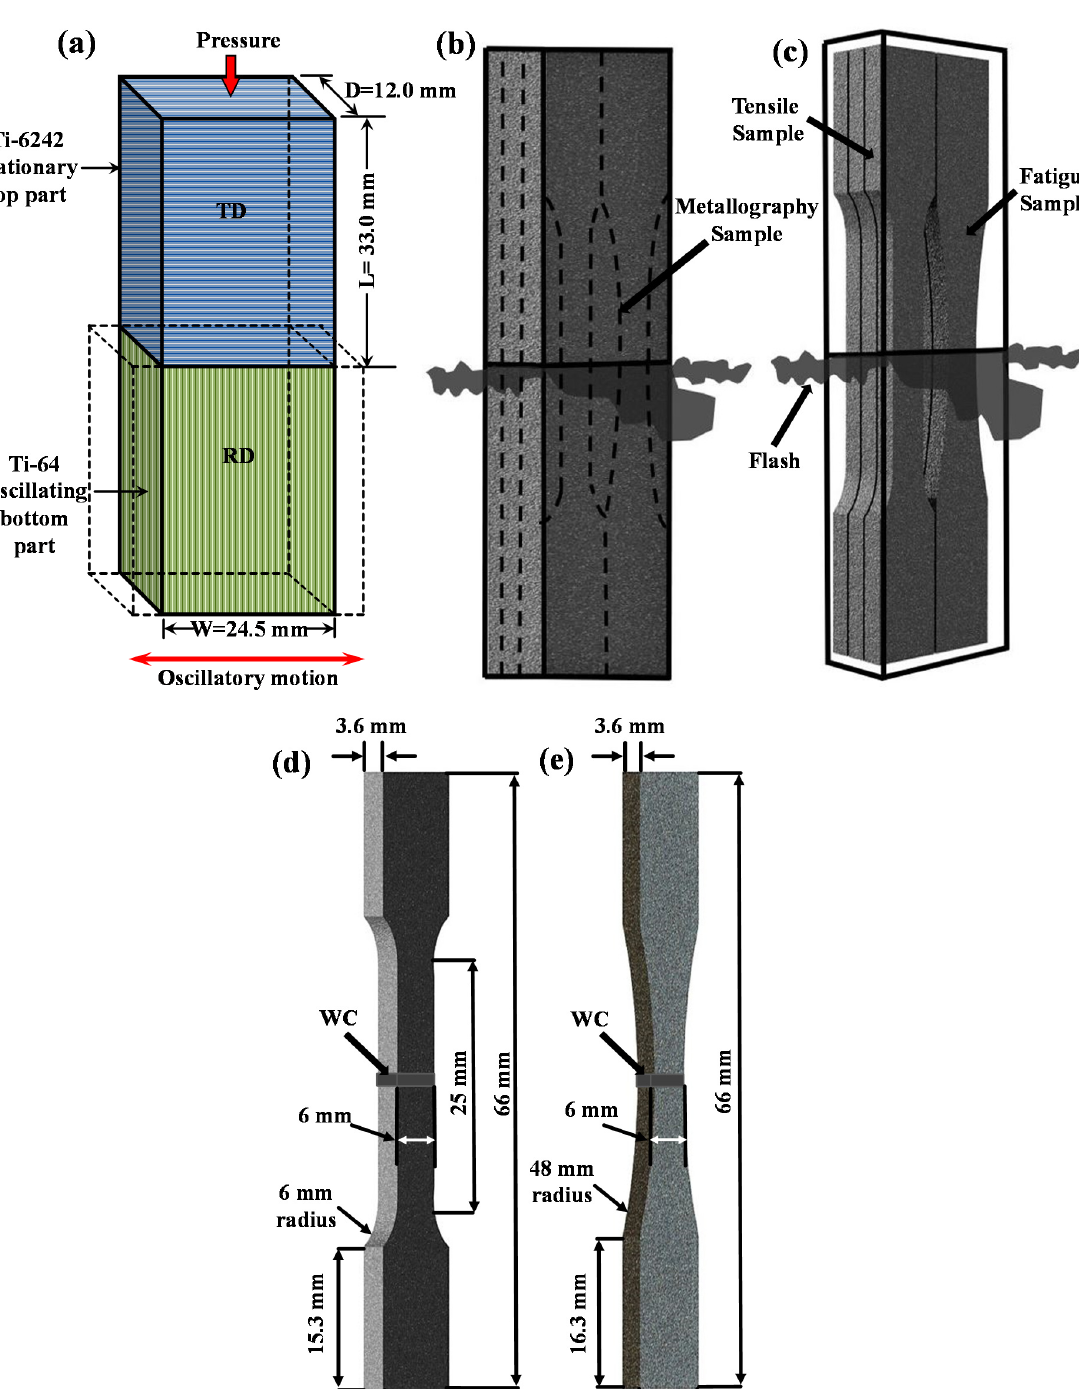
Figure 2. Schematics showing the ( a ) length (L), width (W) and depth (D) dimensions of the Ti64 BM and Ti6242 BM workpieces with the rolling direction (RD) and transverse direction (TD) orientations indicated; ( b , c ) Electro-discharge machining (EDM) plan for extracting the tensile, metallography and fatigue specimens from the welded coupons; ( d ) geometry of the tensile specimens; and ( e ) geometry of the fatigue specimens.